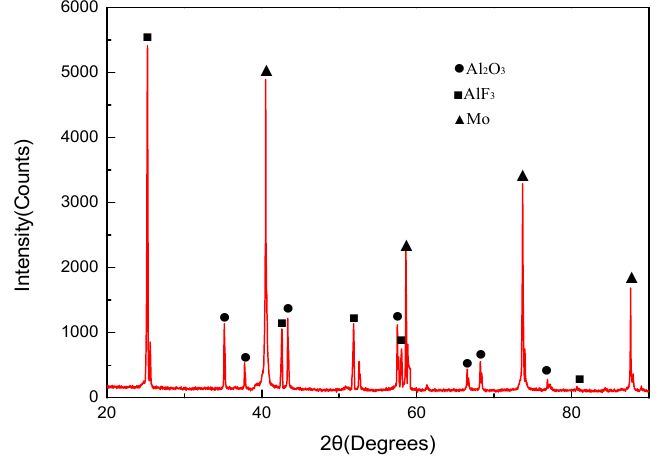
Figure 14. Reaction products of PTFE/Al/MoO 3 after drop-weight tests.